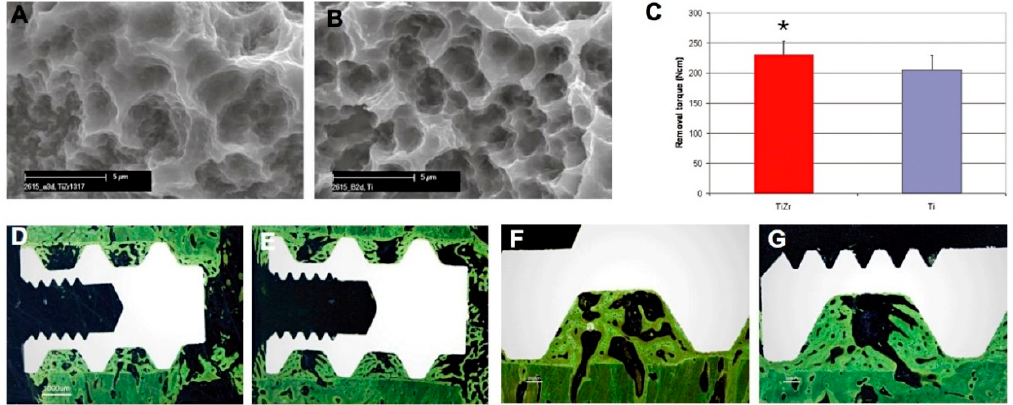
Figure 3. The comparison between and Ti-Zr1317 and Ti implant surfaces.SEM images of ( A ) Ti-Zr1317 and ( B ) Ti surfaces. ( C ) The Ti-Zr1317 implants showed a significantly higher mean value of peak removal torque test than Ti implants (* p < 0.05). Light micrographs in inverted colors of bone chamber implants in ( D , F ) a Ti-Zr1317 specimen and ( E , G ) a Ti specimen [57]. Copyright 2012 Wiley Periodicals, Inc.